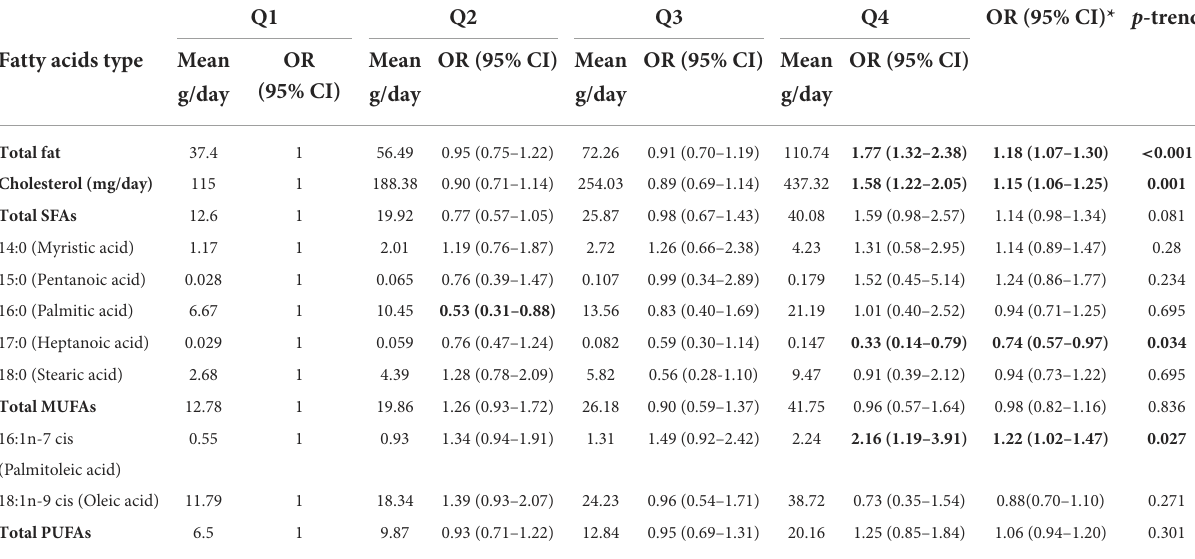
TABLE 2 Dietary estimates of fatty acids and risk of colorectal cancer.